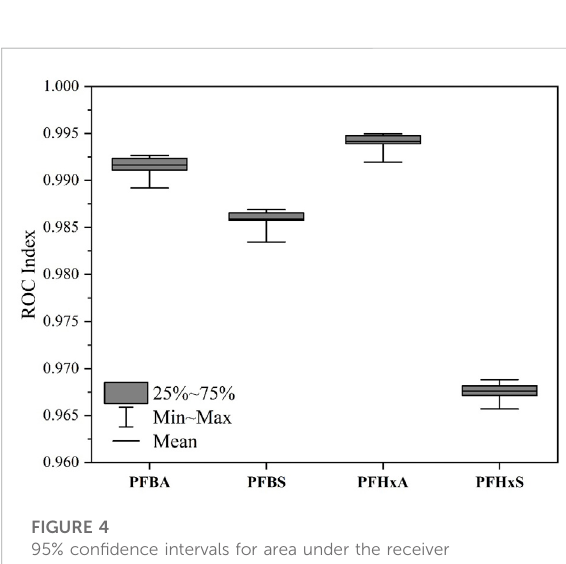
FIGURE 4 95% con fi dence intervals for area under the receiver operating characteristic curve of each model in 5-fold cross- validation. Note: validation was repeated 20